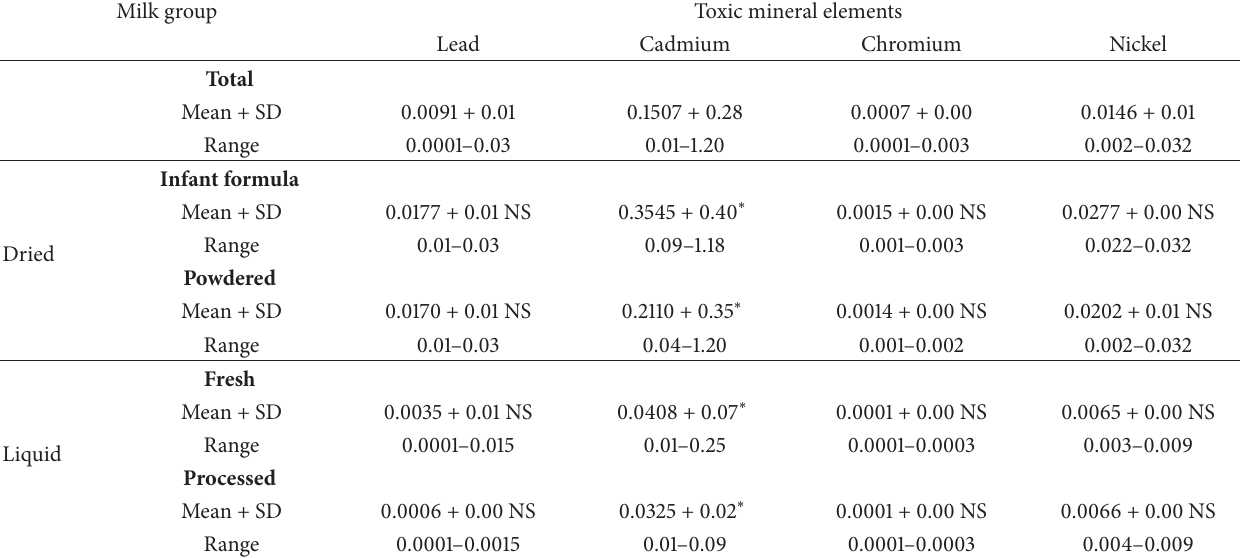
Table 2: Concentration of toxic mineral elements (ppm) in